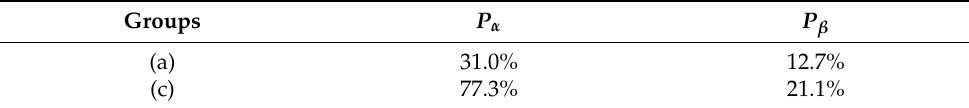
Experiment (iii): Verification experiment under dynamic load torque.